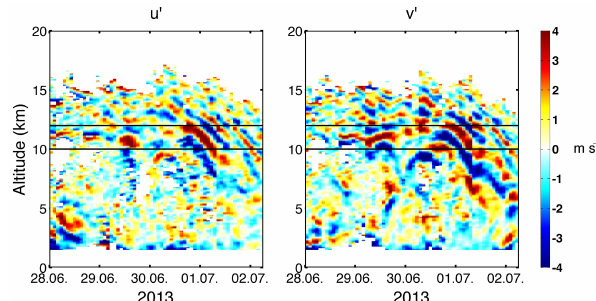
Figure 3. Example of zonal ( u (cid:48) ) and meridional ( v (cid:48) ) horizontal wind perturbations extracted with cutoff vertical wavelength 4km and cutoff period 4h between 28 June and 2 July